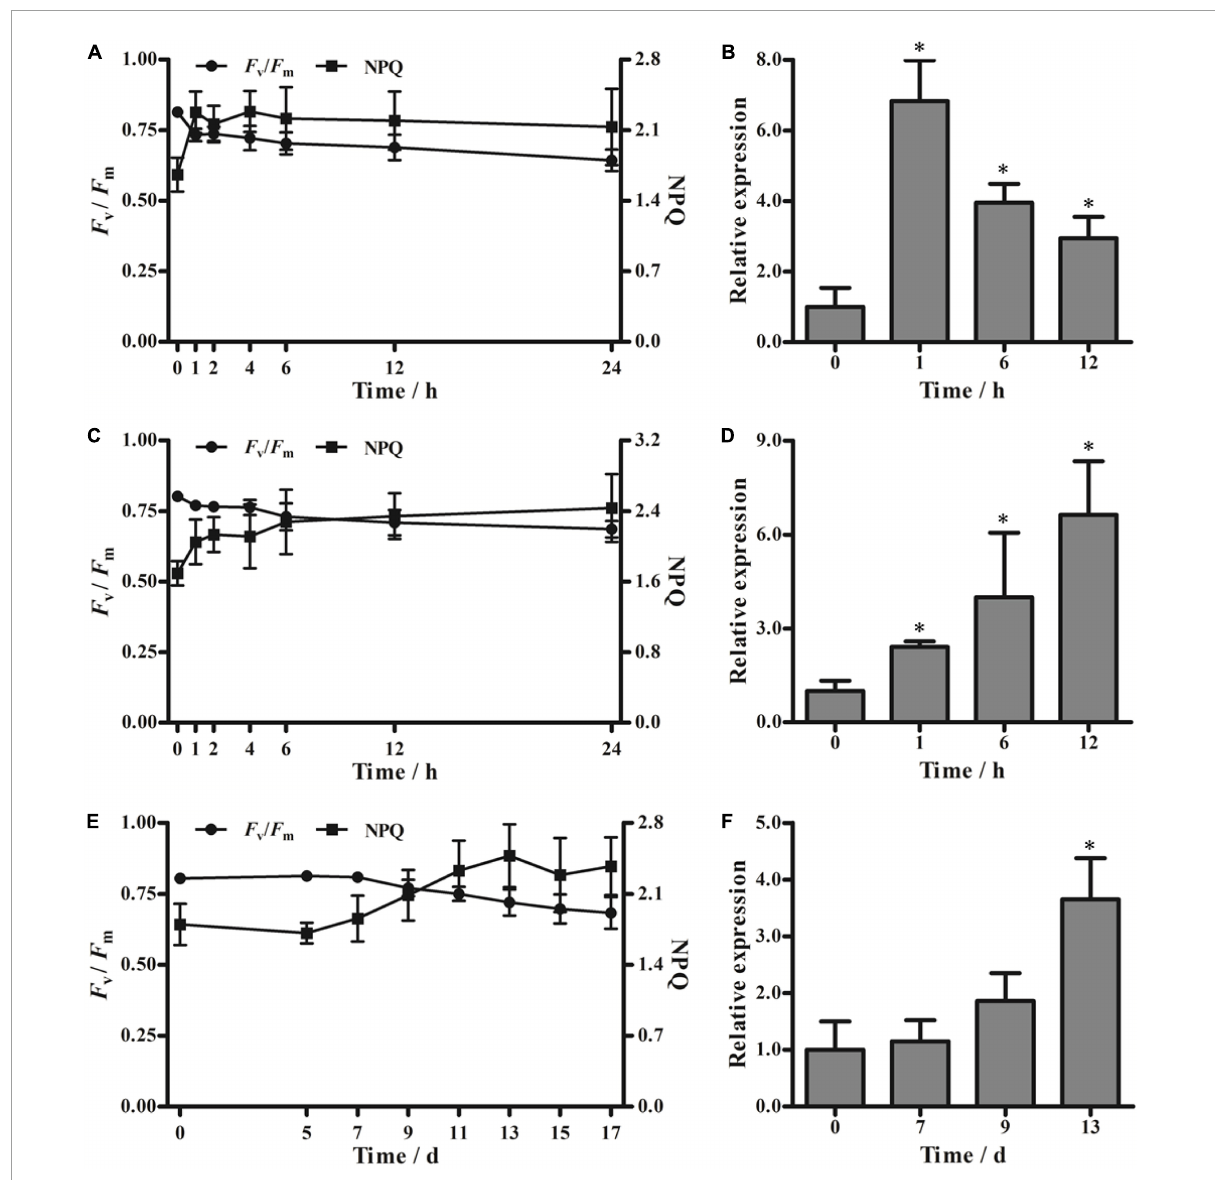
FIGURE4 F v / F m , non-photochemical quenching (NPQ), and PeVDE transcript levels in moso bamboo leaves under different abiotic stresses. (A–F) Values of F v / F m and NPQ (A,C,E) and relative transcript levels of PeVDE (B,D,F) in moso bamboo leaves treated with low-temperature stress (4 ◦ C) (A,B) , high-temperature stress (42 ◦ C) (C,D) , and drought stress (E,F) . NPQ was measured with the actinic light 530 µ mol · m − 2 · s − 1 . Asterisks indicate significant differences ( ∗ p <